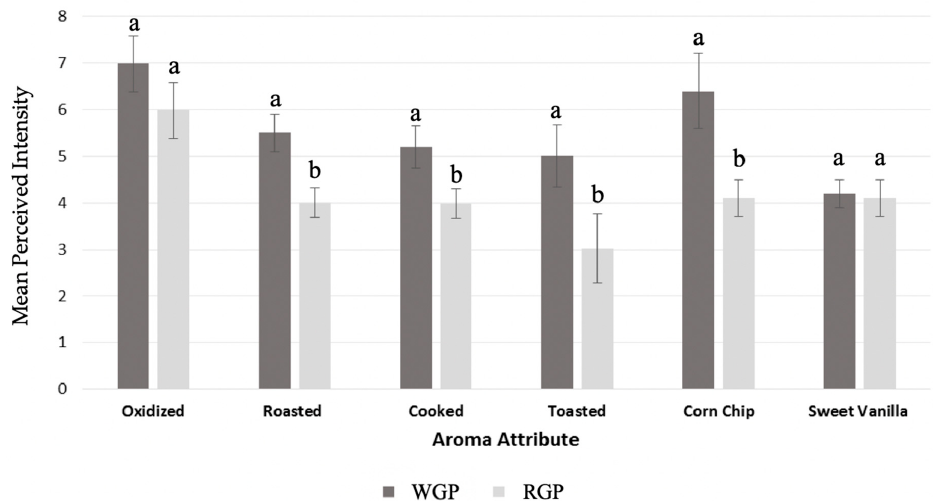
Figure 1. Mean aroma attribute intensity scores of extruded maize refined grain puffs (RGP) and whole grain puffs (WGP); Different letters (a, b) indicate a significant difference between samples for each attribute according to Tukey’s HSD, p < 0.05